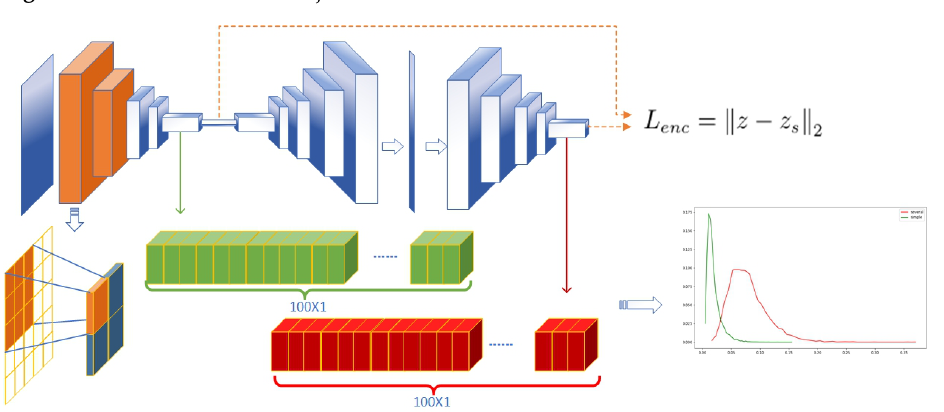
Figure 7. Results of different objects.